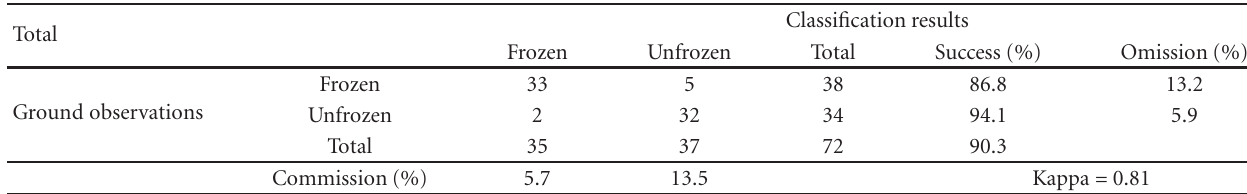
Table 4: Classification results of six selected RADARSAT-1 SAR images compared with soil temperature at the 12 training/validation study fields.